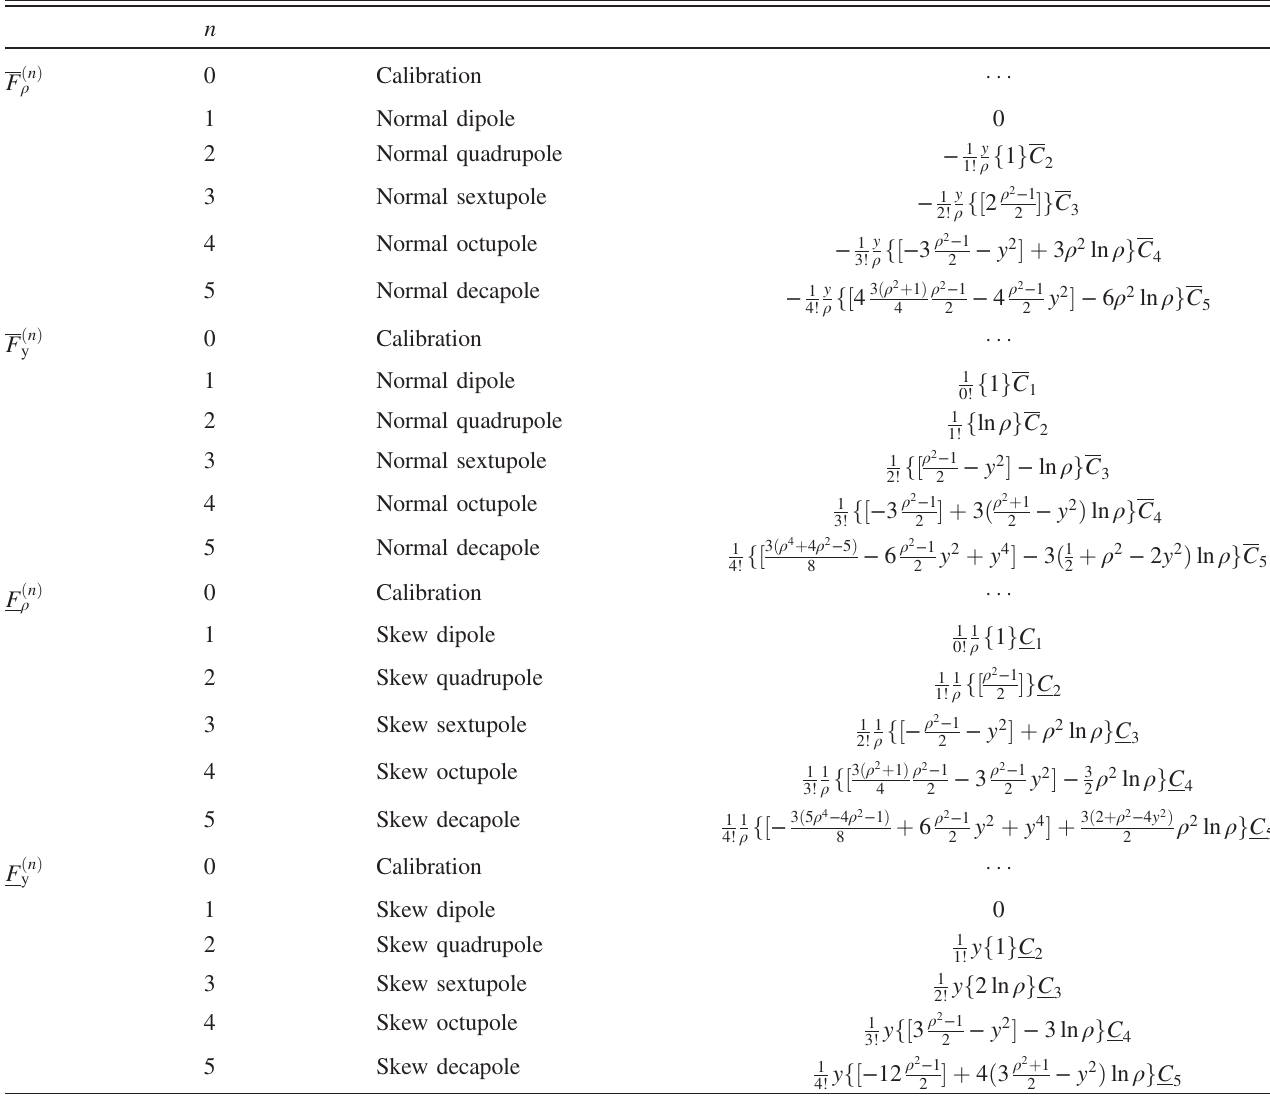
TABLE XII. Radial and vertical components of pure normal and skew S-multipoles ’ field.